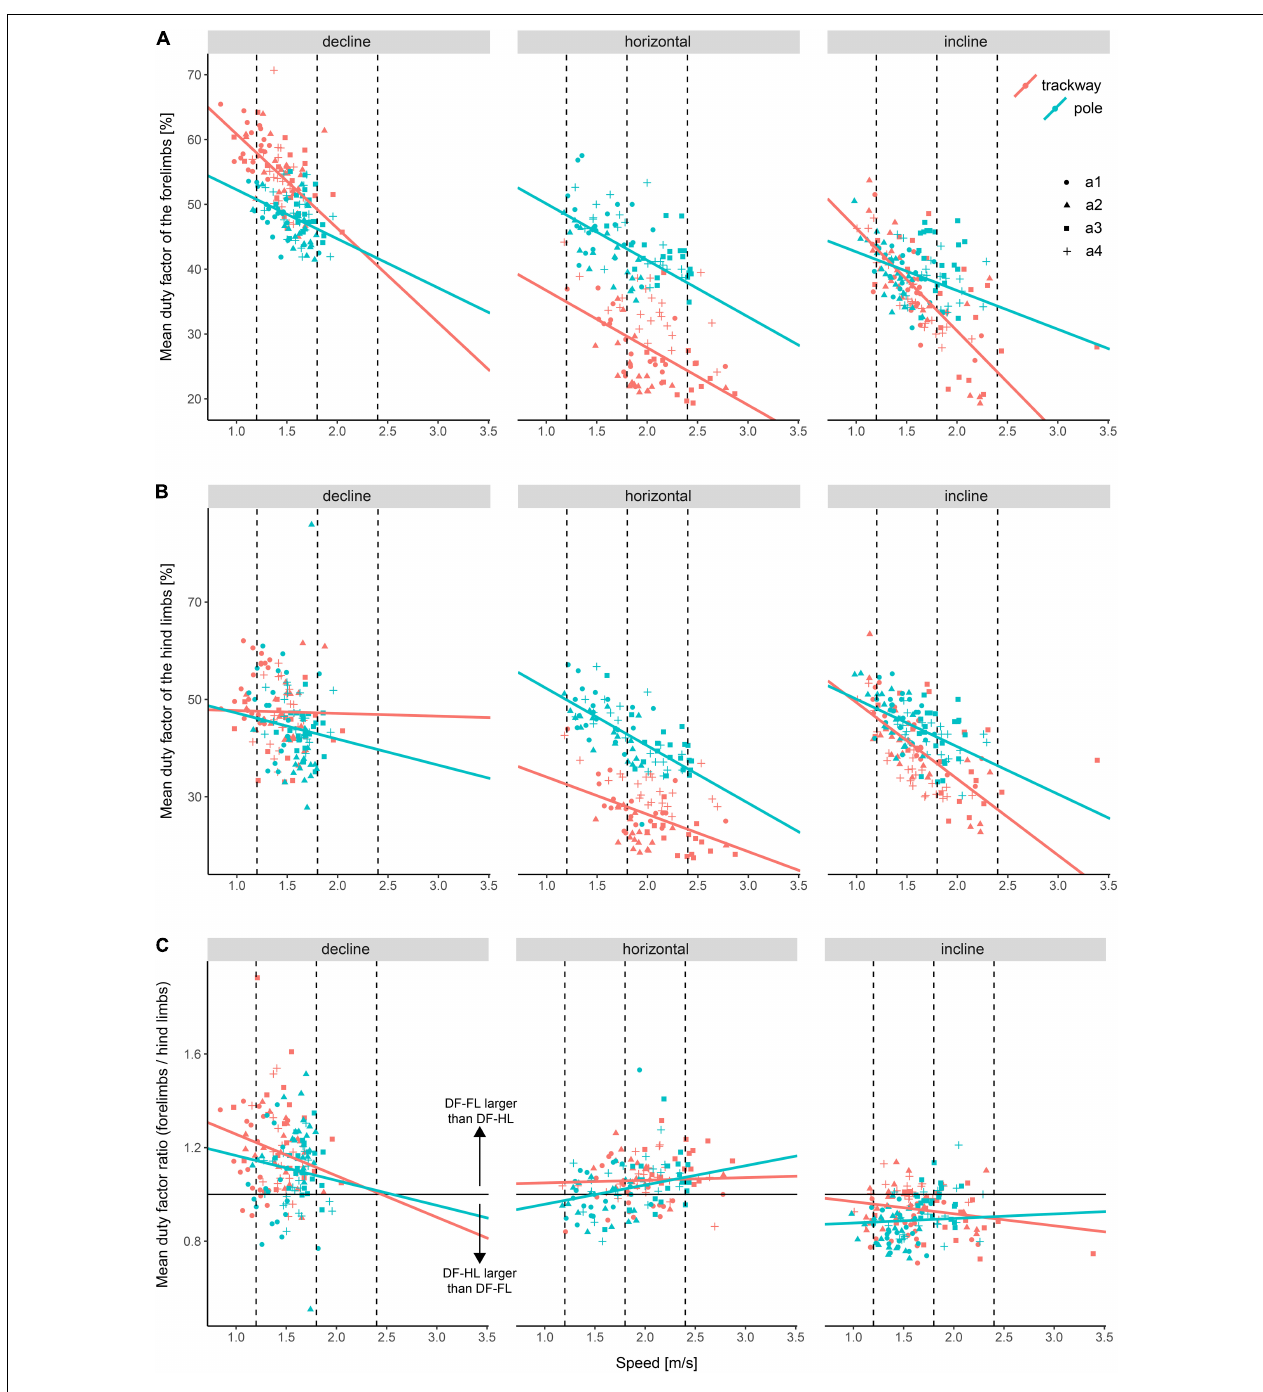
FIGURE 3 | Duty factor differences among experimental setups. (A) Mean duty factor of the forelimbs (DF-FL), (B) mean duty factor of the hind limbs (DF-HL), and (C) Ratio between the two mean duty factors. Dashed lines indicate the speed values at which setups were compared statistically post hoc . a1–a4 refer to the studied